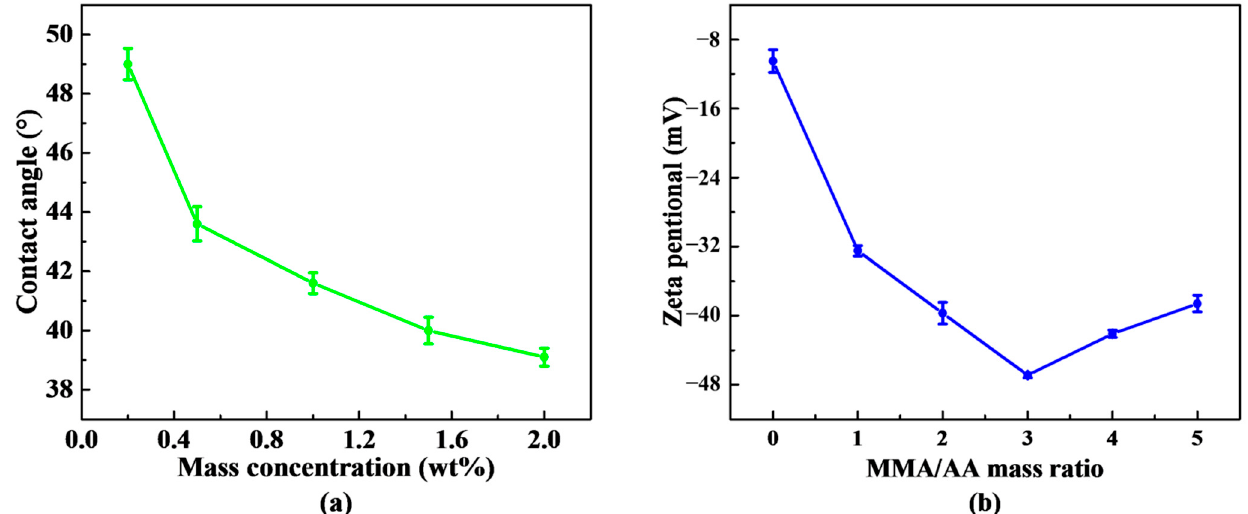
Figure 2. ( a ) Effect of AA mass concentration on contact angles, and ( b ) effect of the MMA/AA mass ratio on the Zeta potential of stabilized soil dust.